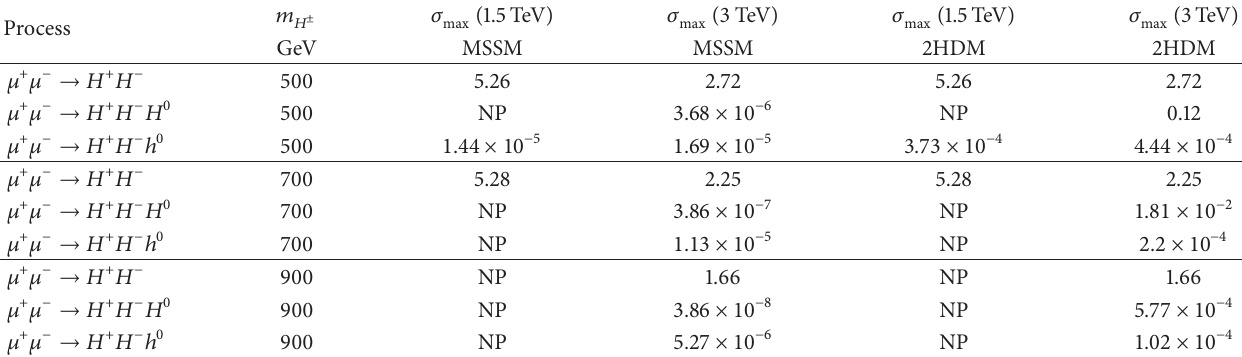
Table 3: The maximum cross section (in fb) for the leading order double Higgs and triple Higgs processes within MSSM and 2HDM at two different centers of mass energies √𝑠 = 1.5 TeV and √𝑠 = 3 TeV.